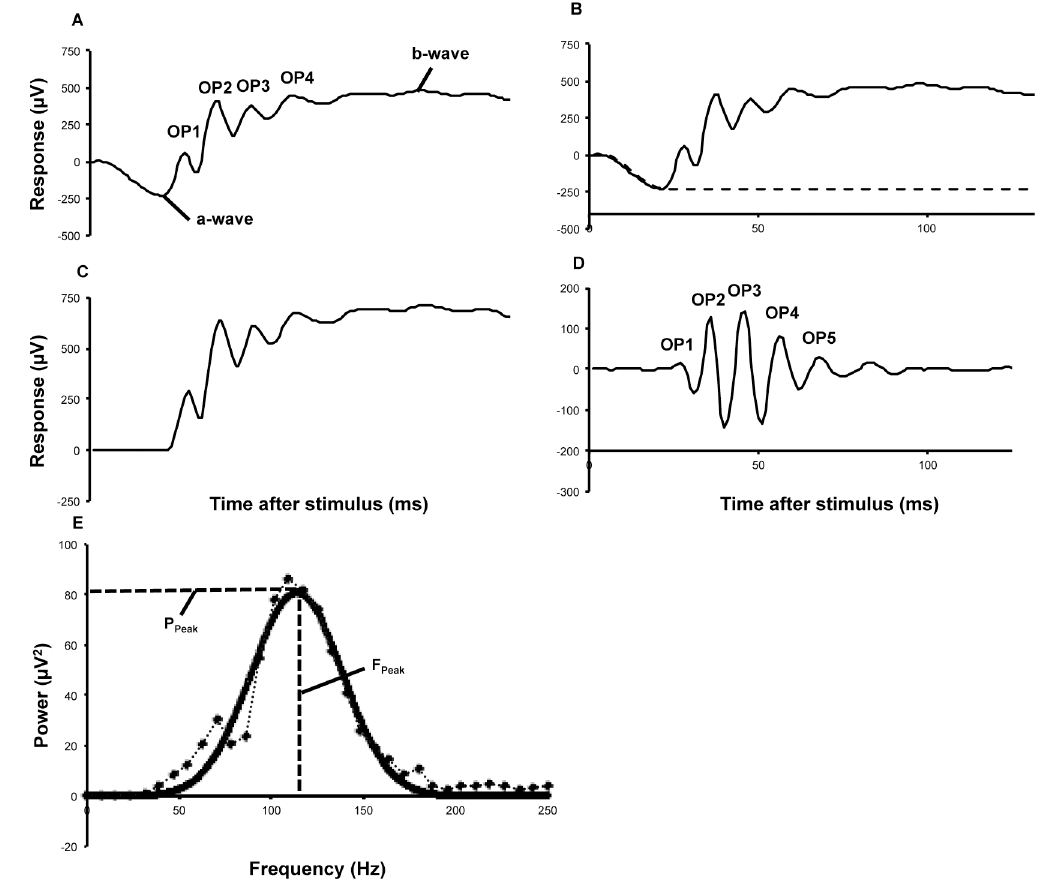
Fig 1. Electroretinogram and OP component modelling. (A) Schematic representation of a trace ERG elicited by a control dark-adapted mouse retina in response to a light stimulus of 25 cd+s/m 2 showing major characteristic components of the scotopic ERG. The ERG has 3 components, the a-wave, b-wave, and the oscillatory potentials (OPs). The OPs are the ascending waves between the a- and b-wave. Signal conditioning of OPs from the ERG trace waveform. (B) A digital subtraction of photoreceptor contribution (dashed line) was performed by a mathematical fitting and subtraction of the a-wave from the initial ERG (solid line). (C) The ERG waveform following complete a-wave digital subtraction. (D) The final waveform was passed through a fifth order Butterworth transformation (65 – 300 Hz) to remove any low or high frequency noise resulting in the final “ OP extracted waveform ” (solid line). Following waveform extraction, measurements of OP implicit time (ms) and amplitude ( μ V) were taken for OP2-5. Amplitude of each OP was defined as the difference between the trough and the peak immediately preceding it. Initial implicit time was defined as the time from stimulus to the onset of the OP2 peak. Interpeak distance was the measurement of time (ms) between adjacent peaks (E) Measurement of individual OP features in the frequency-domain. A fast Fourier transform (FFT) was applied to the extracted OP waveform and gave a single-sided smoothed frequency power spectrum (dotted line). The single-sided smoothed frequency power spectrum was fitted to a two-term Gaussian envelope (solid line) and measurements of peak power (P peak ), peak frequency (F peak ) and total energy (waveform integration) were